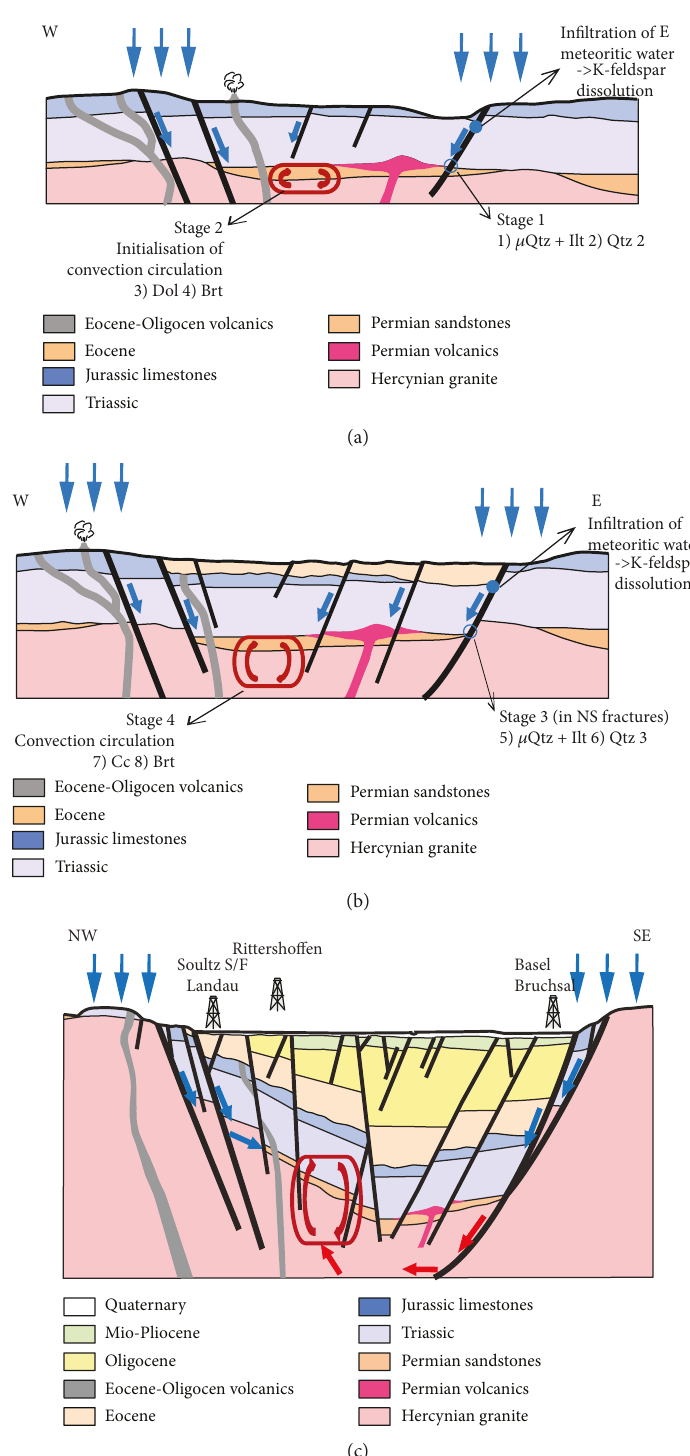
Figure 15: Schematic of fl uid circulation and rock interaction during Tertiary tectonic episodes. (a) Early rifting stage during the Eocene under N-S compression associated with the paleo fl uid stages 1 and 2. (b) Lower Eocene and Oligocene rifting under E-W extension associated with paleo fl uid stages 3 and 4. (c) Present-day situation; location of geothermal sites is indicated as an approximate projection. Conceptual cross sections modi fi ed from Sittler (1992). Vertical scale is exaggerated. Blue arrows: meteoritic waters; red arrows: hot brines; curved arrows: convection cell. See explanation in the